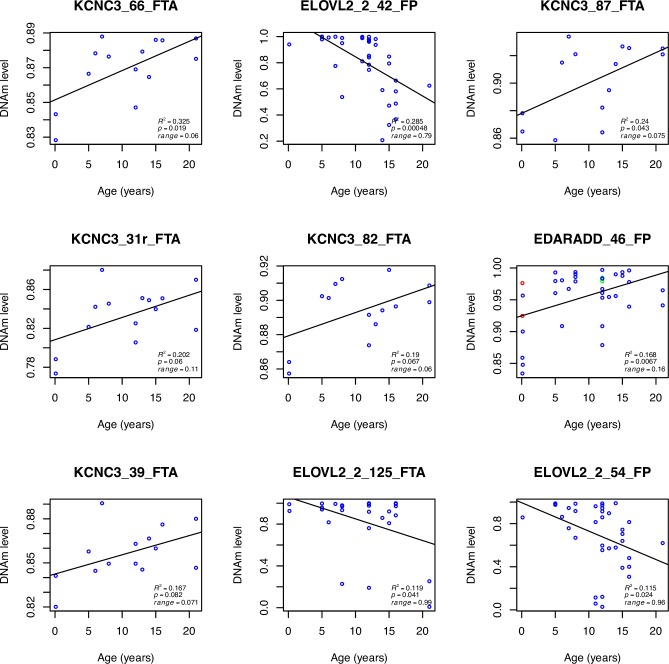
Methylation profiles by MiSeq analysis.Association of individual seabird proportion of cytosine methylation (y-axis) against age in years (x-axis) for the top nine CpG sites in blood (FTA) and feather (FP) samples. The best relationship with age based on R2 is shown from the top left to bottom right. A measure of the magnitude of DNAm change with age is also shown. A technical replicate is shown in red whilst a run replicate is shown in green in the EDARADD methylation plot.